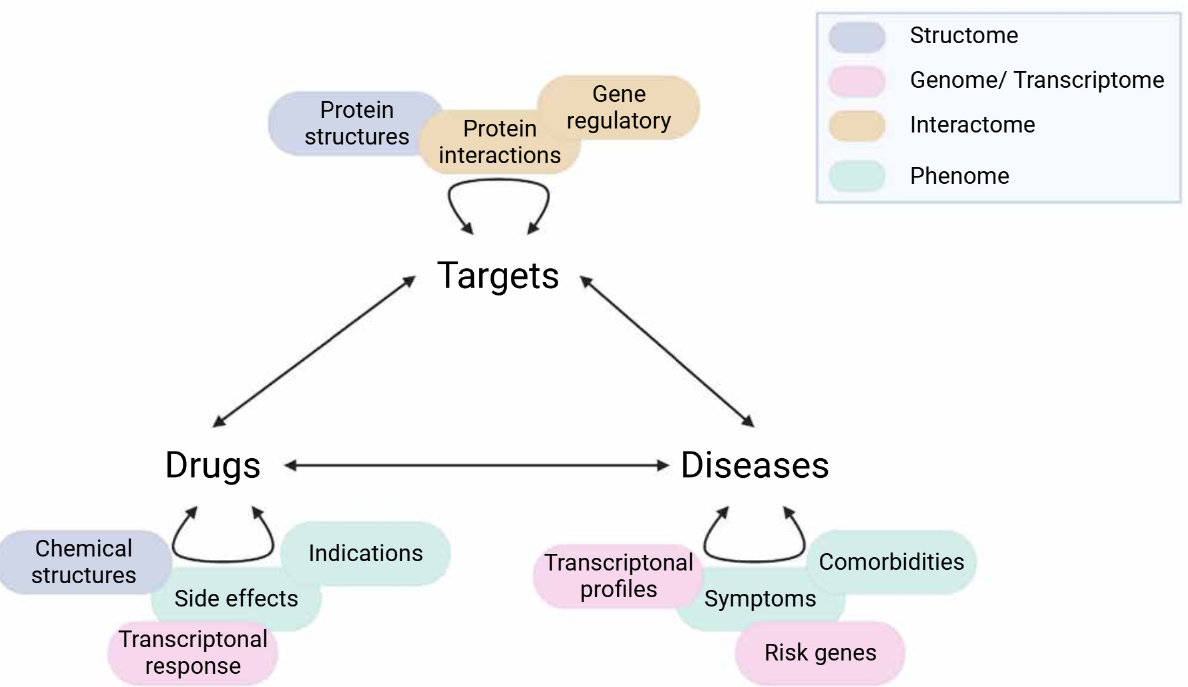
Figure 5. Different data sources for network-based drug repurposing. Curved arrows represent the associations of entities within one type (e.g., drug–drug). Multiple data sources (coloured correspondingly to their main domains such as transcriptome) can be applied to infer these associations, usually for the creation of similarity or interacting networks. Straight arrows represent the relationships between entities of different types (e.g., drug–target). For drug repurposing, the aim generally is to find a latent drug–disease connection, which can be achieved by taking the inference route from Drugs–Targets–Diseases (and vice- versa) as in the ABC model, or via Diseases–Diseases–Drugs (or Drugs–Drugs–Diseases) as in the GBA model. Created with BioRender.com (accessed on 2 June 2022).